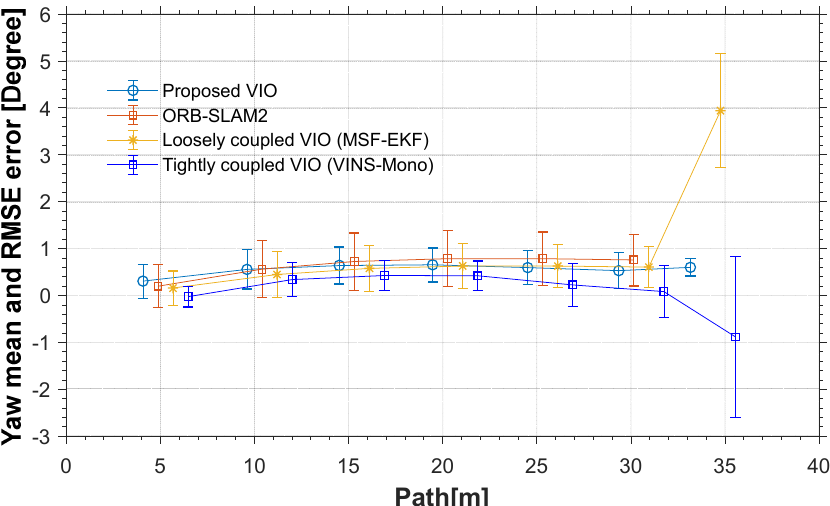
Figure 16. ( a ) The value of fault detect function demonstrates the dramatic change. ( b ) An illustration of the value of position and yaw observation noise.